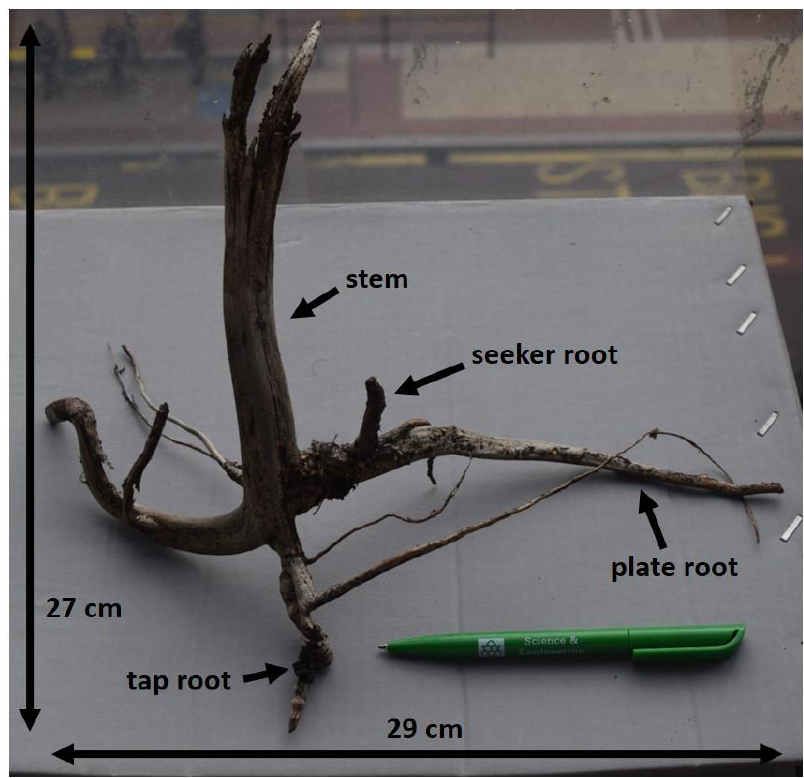
Figure 8. A small-diameter subfossil pine tree ( P. sylvestris ) recovered from the uppermost layers of peat containing bog-pine woodland at Lindow Moss, Cheshire (stem top broken by machinery during mechanised peat extraction). Note the presence of seeker roots, a likely response to prolonged waterlogging.